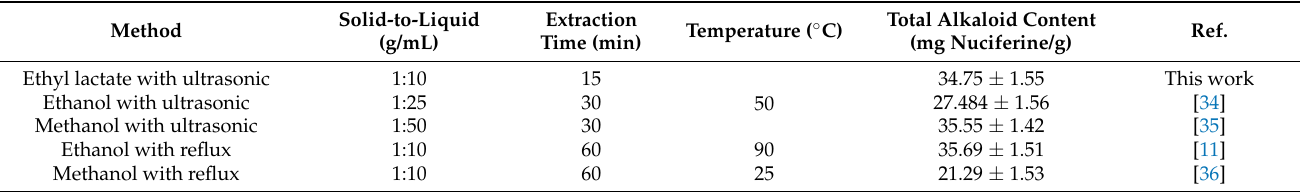
Table 1. The total alkaloid content extracted from lotus seed epicarp by different extraction methods.